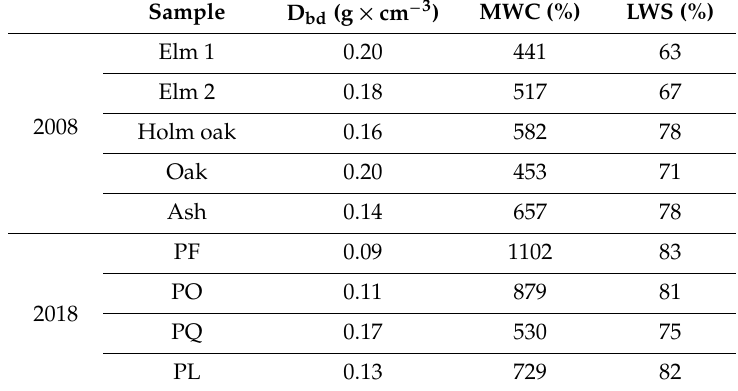
Table 4. Results of physical characterization of Pisa wood samples. Data of 2008 analyses from: Cragnolini, E.; Sarra, A. Sperimentazione di metodi di impregnazione e liofilizzazione di